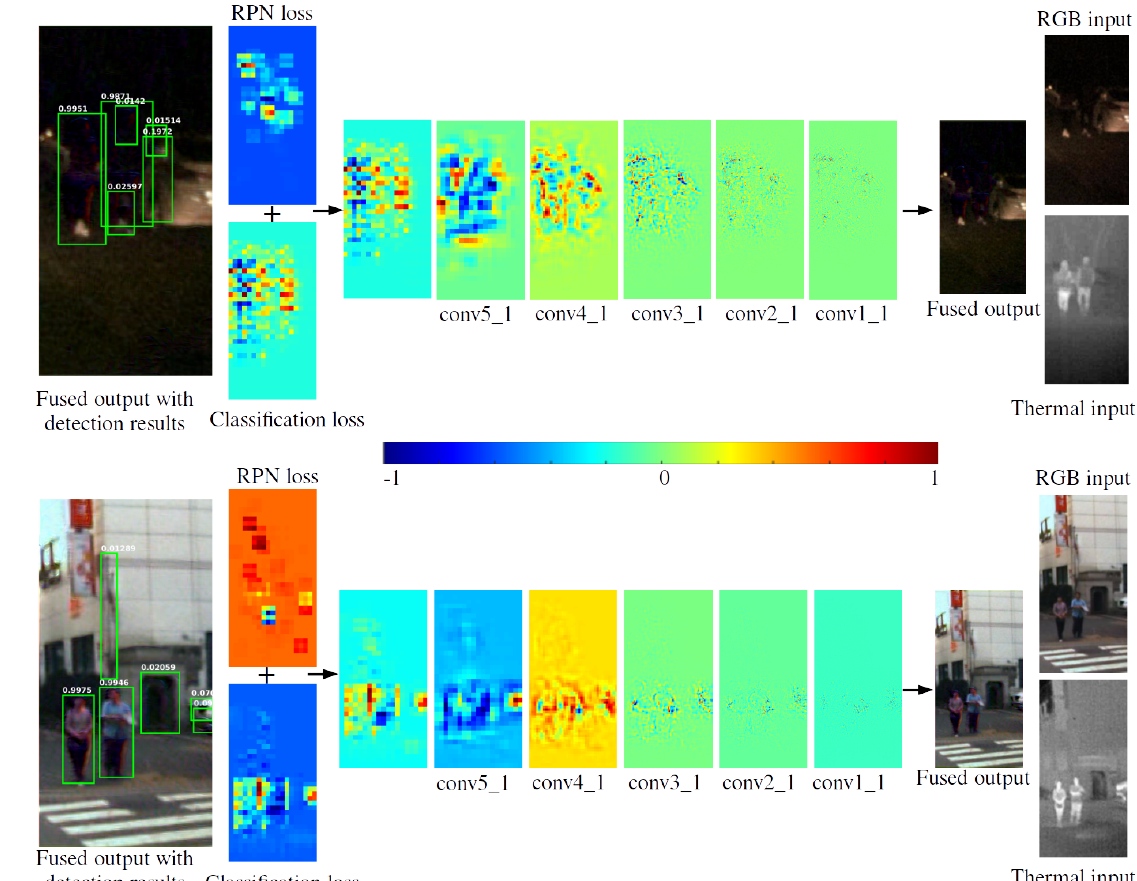
Figure 4. Normalized examples of the error gradients for the fused outputs calculated from the detection loss. The figure shows the propagation of the gradients from the region proposal and classification sub-networks through the VGG-16 feature layers, towards the trainable fusion network. The values shown here are normalized in the range [ − 1,1 ] for each map separately for visualization